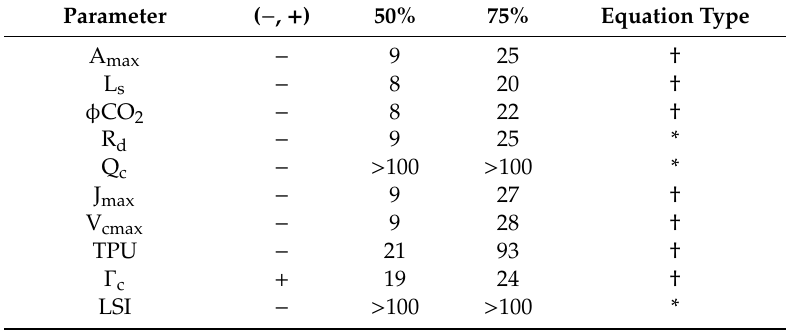
Figure 6. Maximum photosynthesis (A max ) at crown layer 3 (the lowest crown position) of hemp leaves as a function of leaf age. Binned averages per three-day collection sequence (means ± SE), where samples were pooled for treatments and crown position. Sample size in bins indicated by bubble diameter (n = 3–18 for A max ). Solid line is a logarithmic regression curve fitted to the leaf age data set. Table 2. Days after full leaf expansion when an estimated decrease or increase ( − , + ) of 50% and 75% from the maximum mean physiological parameter value occurred. Samples were pooled for treatments and crown position, and estimates were calculated with either a linear (*) or logarithmic ( † ) equation. Leaf respiration rate (R d ), quantum yield ( φ CO 2 ), maximum photosynthesis (A max ), leaf light saturation (L s ), light compensation point (Q c ), maximum electron transport rate (J max ), maximum Rubisco carboxylation rate (V cmax ), triose phosphate utilization (TPU), CO 2 compensation point ( Γ c ), and leaf spectral index (LSI, a proxy for leaf nitrogen content, chlorophyll a + b concentration, and greenness characteristics) versus leaf age. Total number of leaves =